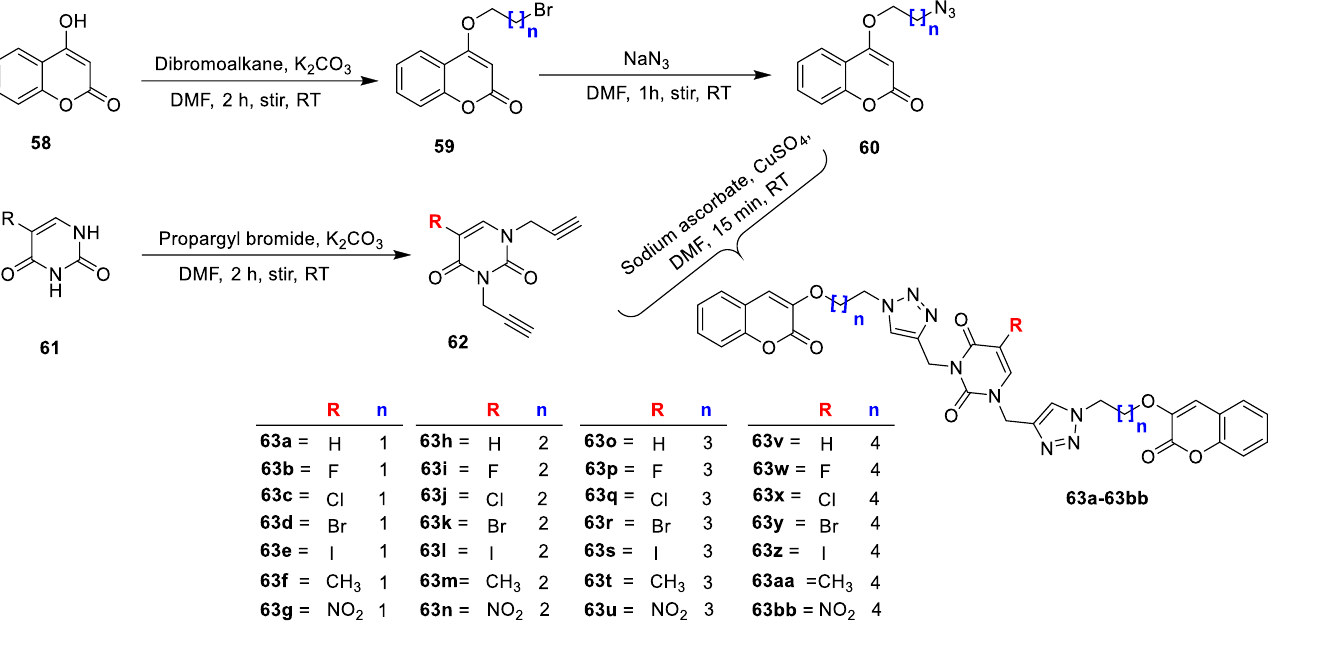
Scheme 8. Synthesis of uracil—coumarin hybrids. Reproduced and adapted with permission